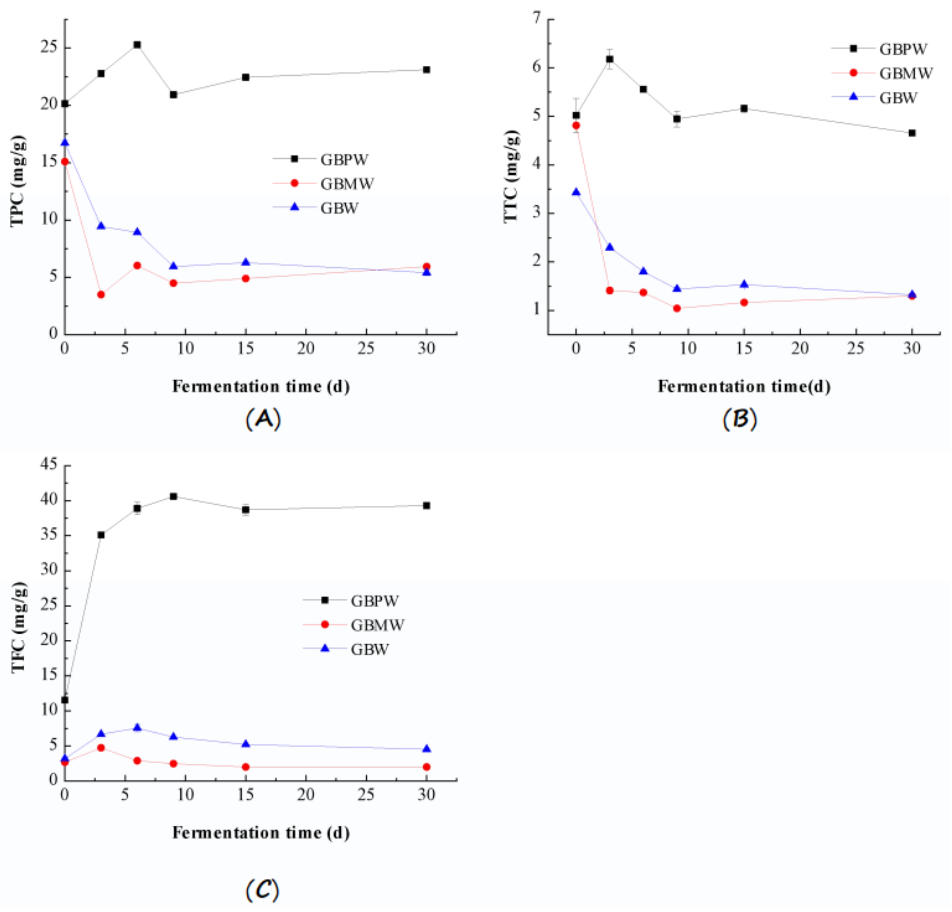
Figure 2. Changes in bioactive components of GBPW, GBMW, and GBW during fermentation of green banana samples. ( A ) Total phenolic content (TPC); ( B ) total tannin content (TTC); ( C ) total flavonoid content